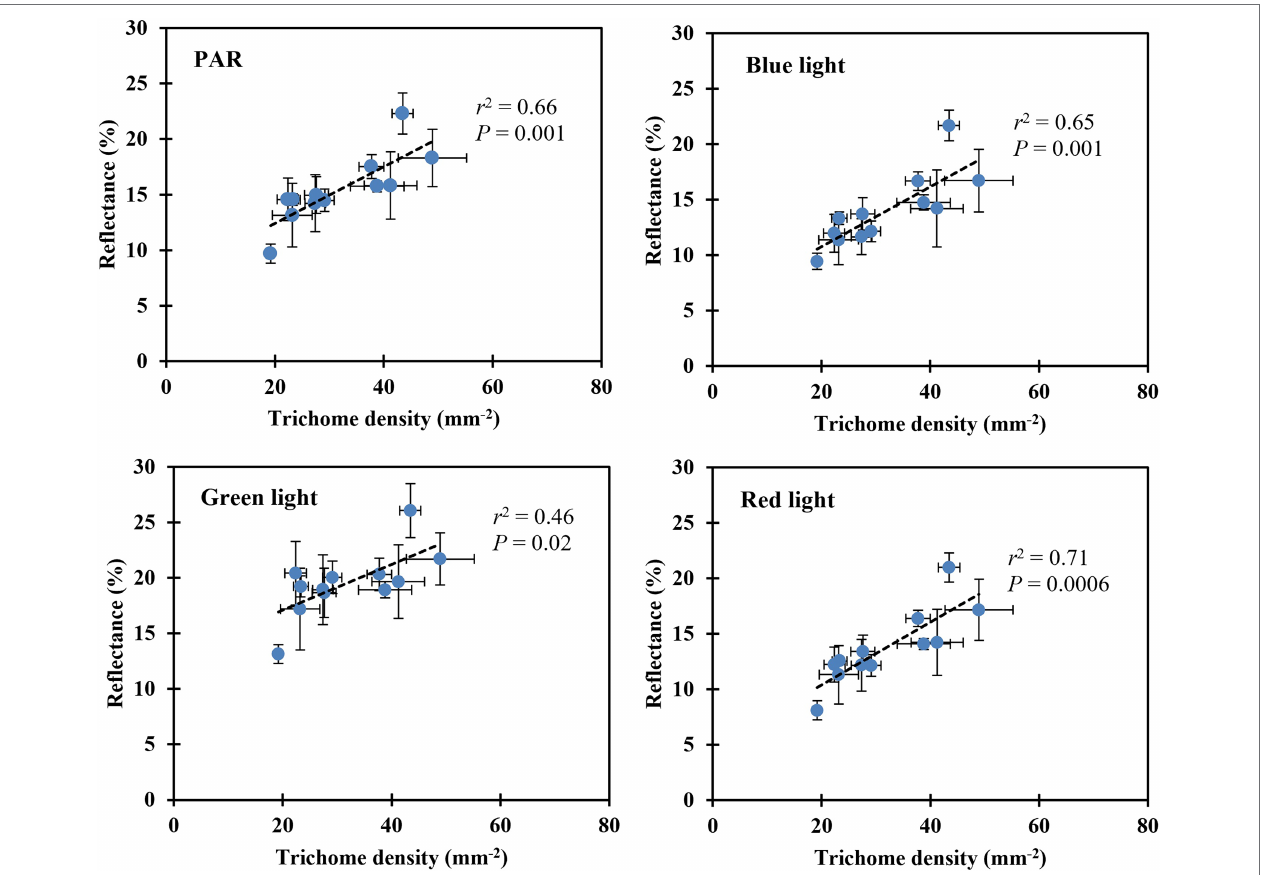
FIGURE 6 | Correlation between the leaf upper (adaxial) surface trichome density and reflectance of PAR, blue, green, and red light. The reflectance of PAR was determined using the mean reflectance between the wavelengths ( λ ) ranging from 400 to 700 nm. The reflectance of blue, green, and red light was determined using the λ at 450, 530, and 660 nm, respectively (Kusuma et al., 2020). The error bars represent the SEs of three leaves sampled from each